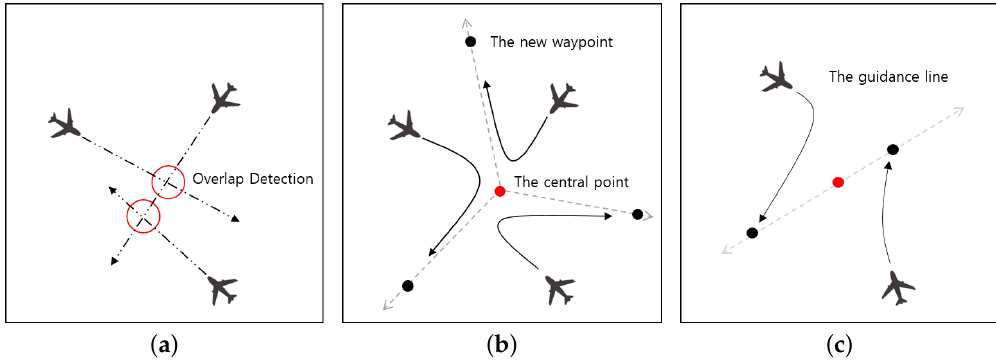
Figure 3. Examples of overlap avoidance: ( a ) Overlap detection; ( b ) generating guidance lines among three UAVs; and ( c ) generating a guidance line between two